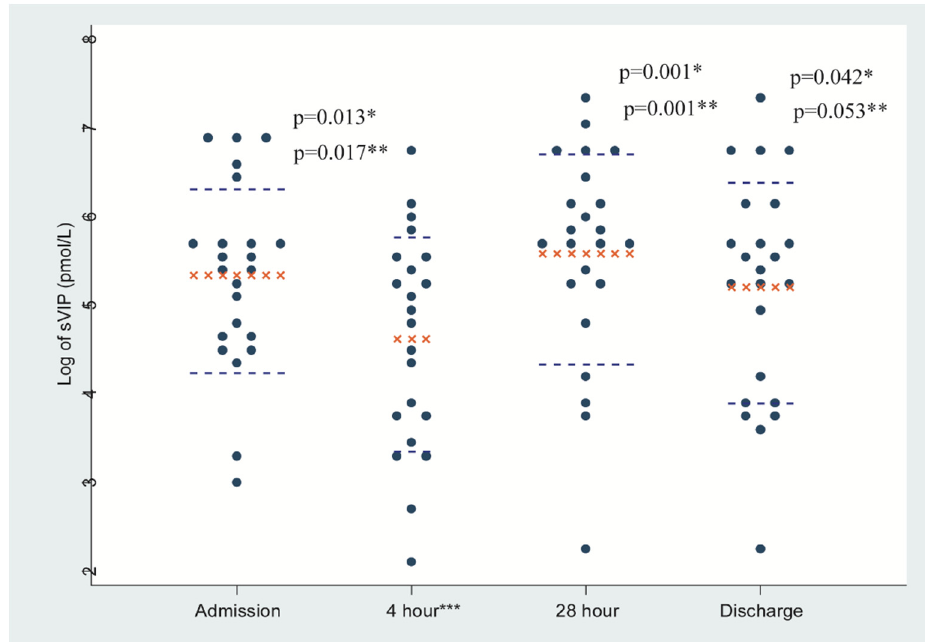
Figure 1. Distribution of average values of stool VIP after log transformation.